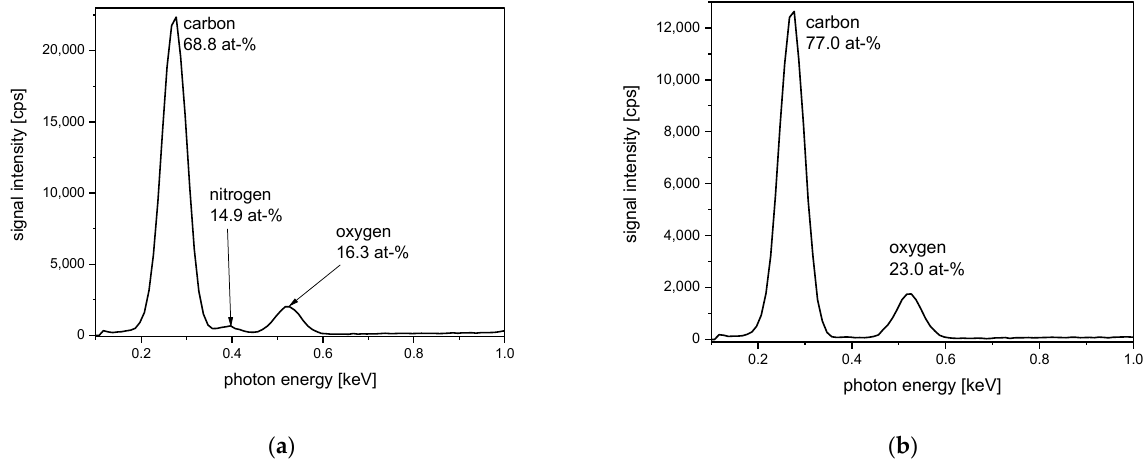
Figure 7. EDS spectra taken from aromatic high-strength fibers—( a ) aromatic polyamide (para-aramid)—Kevlar; ( b ) aromatic polyester—Vectran fiber.